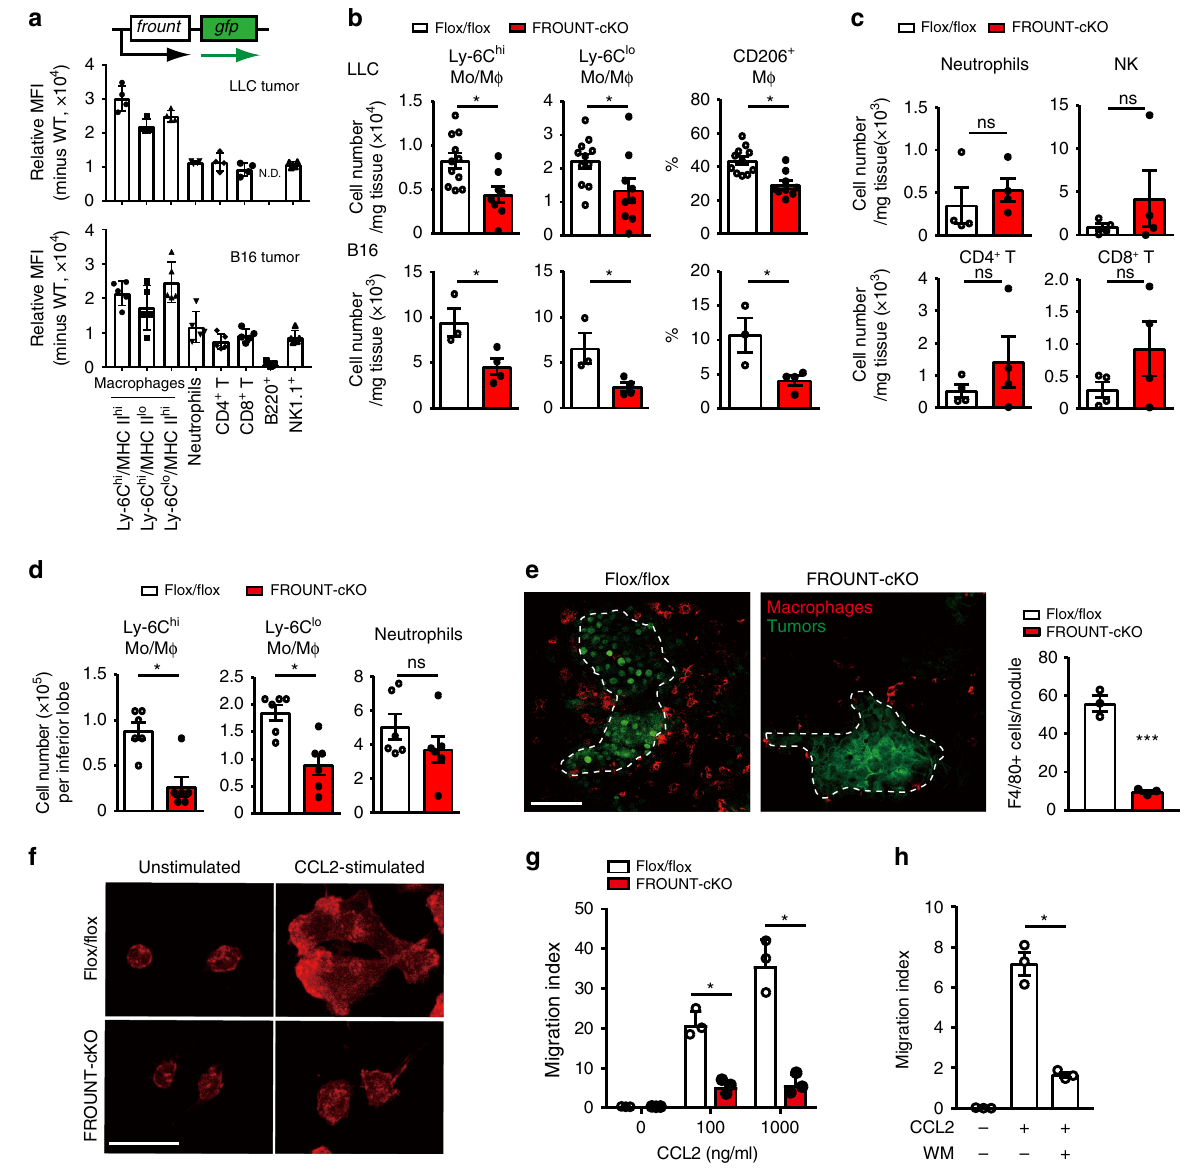
Fig. 3 FROUNT de fi ciency impaired monocyte/macrophage accumulation at tumor sites. a FROUNT protein expression in LLC- or B16-tumor-in fi ltrating leukocyte subsets (monocytes/macrophages subsets; Ly-6C hi /MHC class II hi , Ly-6C hi /MHC class II lo and Ly-6C lo /MHC class II hi , Neutrophils, CD4/8 T cells, B cells and NK cells) in FROUNT-GFP reporter mice as measured by fl ow cytometry ( n = 4 for LLC and n = 5 for B16). b Numbers of tumor- associated Ly-6C hi or Ly-6C lo monocytes/macrophages (Mo/M ϕ ) and proportion of CD206 + M2-type macrophages among total macrophages (CD45 + CD11b + CD24 − Ly-6G − cells in leukocyte gate) in subcutaneous LLC (Flox/ fl ox: n = 11, cKO: n = 9) and B16 (Flox/ fl ox: n = 3, cKO: n = 4) tumors from Flox/ fl ox or FROUNT-cKO mice. c Numbers of tumor-associated neutrophils, NK cells, CD4 + , and CD8 + T cells in B16 tumors ( n = 4). d Numbers of monocytes/macrophages and neutrophils in metastatic lungs ( n = 6). e Confocal microscope images of macrophage accumulation (F4/80, red) around B16 lung metastatic nodules (green, broken outline). Three visual fi elds were averaged. f Pseudopodia protrusion of macrophages (F-actin staining, red), g monocyte (CD11b + Gr-1 − Ly-6C + ) chemotaxis and h effect of wortmannin (WM) ( n = 3). Gating strategies to identify the immune cell populations are shown in Supplementary Fig. 10. * P < 0.05, *** P < 0.001 by a two-tailed, unpaired Student ’ s t -test. ns not signi fi cant. Error bars indicate s.e.m. Scale bars, 50 μ m. N.D. not determined, MFI mean fl uorescence